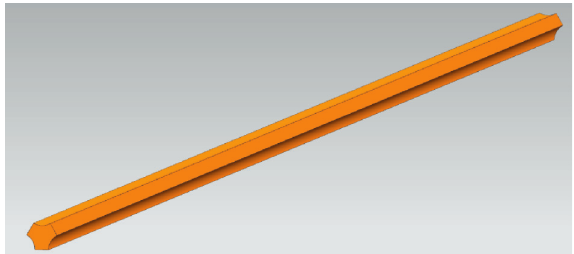
Figure 1: Geometric model.